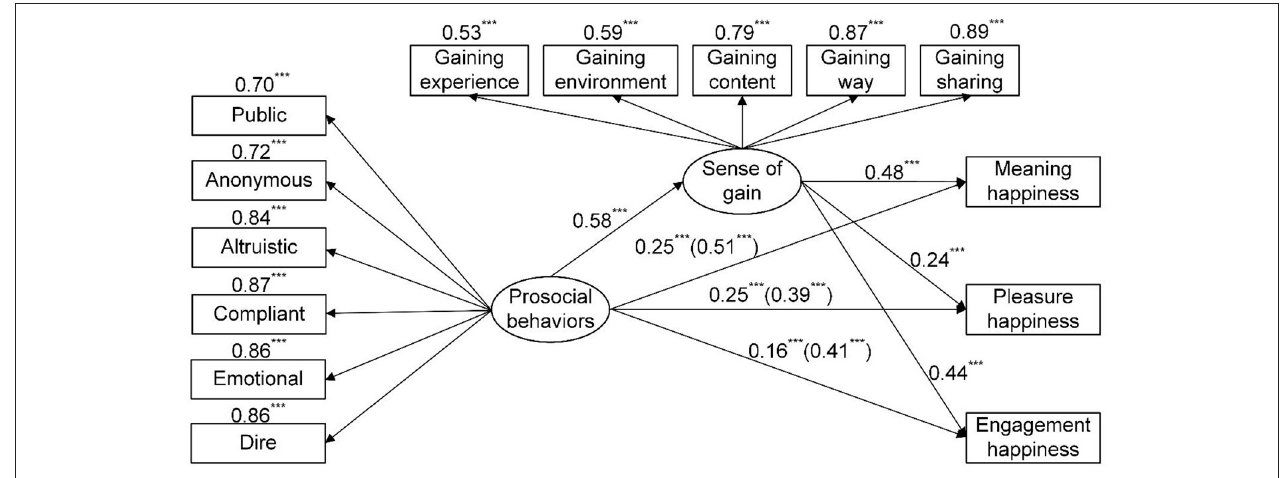
FIGURE 1 | Relationship model and standardized path coefficients of prosocial behaviors, sense of gain and three types of happiness. *** p < 0.001.